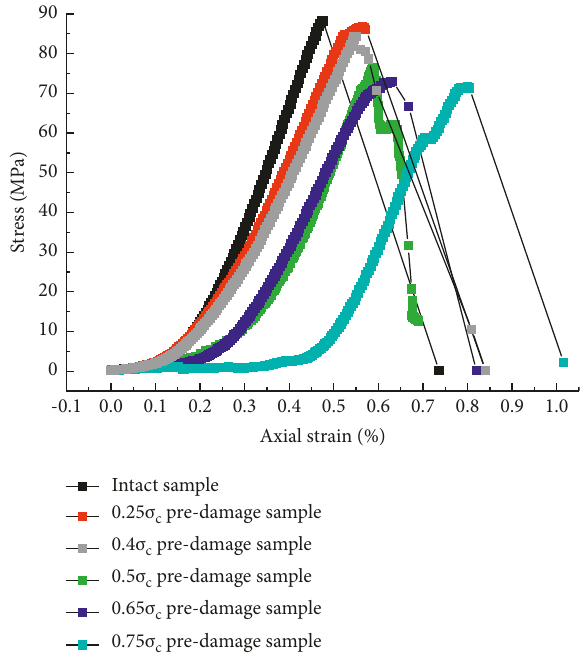
Figure 5: Stress-strain curve pre-damaged